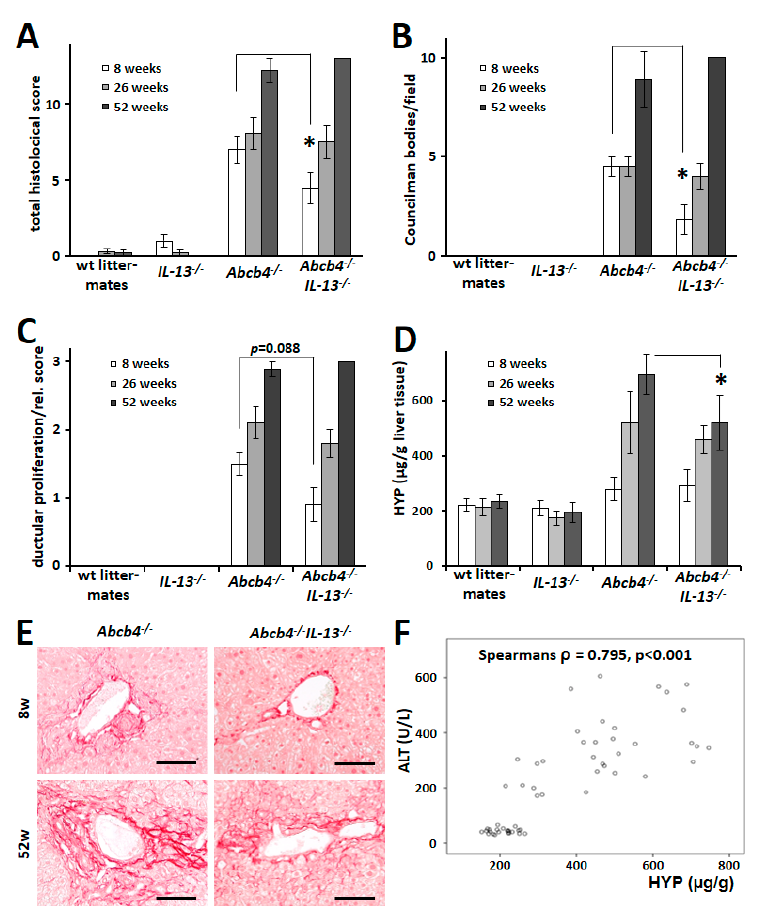
Figure 3. IL13 knockout reduced hepatic pathology and fibrosis in Abcb4 − / − mice. ( A – C ) Histological scoring revealed an ameliorated total histological score ( A ) and a reduced number of apoptotic hepatocytes ( B ) in 8-week-old Abcb4 − / − / IL-13 − / − mice ( p = 0.047 and p = 0.018, respectively), while pathologic assessment of bile duct proliferation failed to reach statistical di ff erence ( C ). ( D ) Quantitative assessment of hydroxyproline (HYP) showed reduced hepatic accumulation of fibrillary collagen in 52-week-old Abcb4 − / − / IL-13 − / − mice, Values are means ± SEM. * p < 0.05 Abcb4 − / − vs Abcb4 − / − / IL-13 − / − . ( E ) Sirius-red staining demonstrated reduced chicken wire fibrosis along with sinusoids and loosened periportal fibrillar collagen deposition in 52-week-old Abcb4 − / − / IL-13 − / − mice. Magnification 200 × , bars 100 µ m. ( F ) Serum ALT correlated well with hepatic HYP